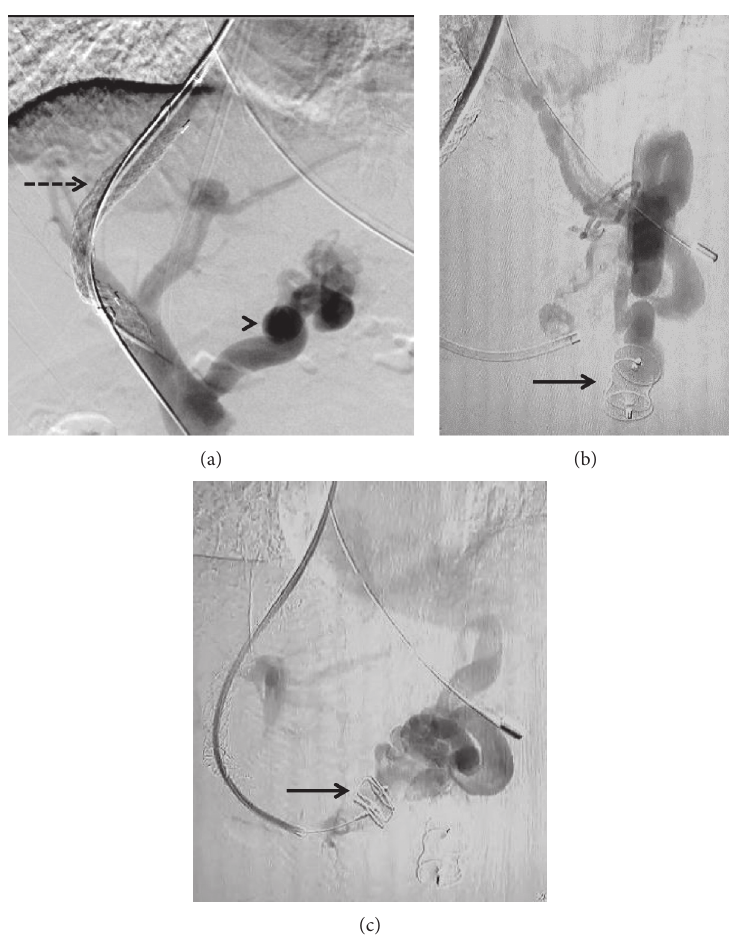
Figure 11: Axial (a, b) and coronal (c, d) CECT images depicting gastric varices (encircled in (a, b) in a 74-year-old patient with liver cirrhosis and intractable gastric variceal bleeding. Post-PARTO images (c, d) show completely thrombosed varices (encircled in (c, d)) with vascular plug-in-situ (arrow in (d)). Note. The interval increase in the caliber of main portal vein and its intrahepatic branches (dashed arrows).